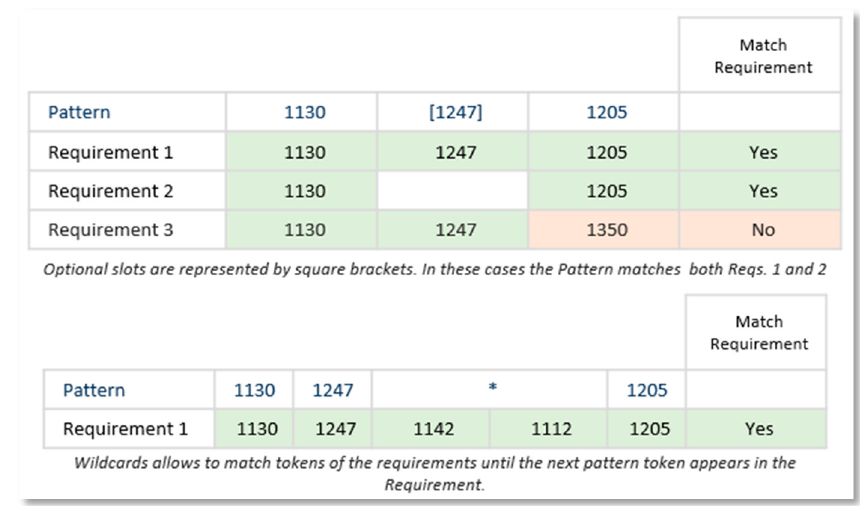
Figure 5. Special patterns slots: Optional slots represented with brackets and wildcard tokens, represented with an asterisk.